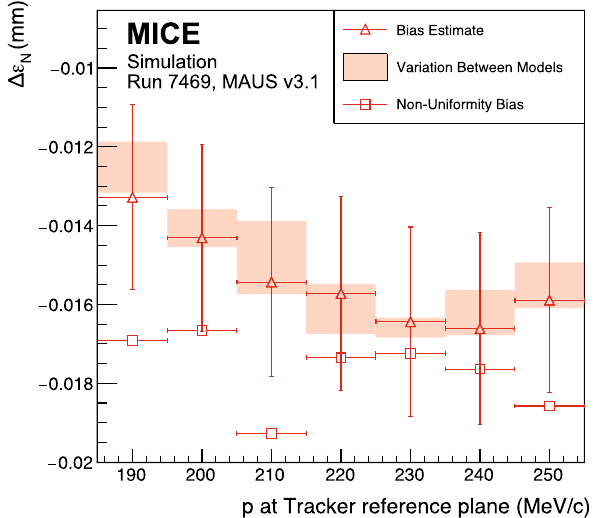
Fig. 8 The systematic bias and uncertainty on the reconstructed emit- tance under different magnetic field model assumptions. The bias esti- mate (open triangles) includes the non-uniformity bias (open squares). The variation between the models (see text) is indicated by the shaded bands